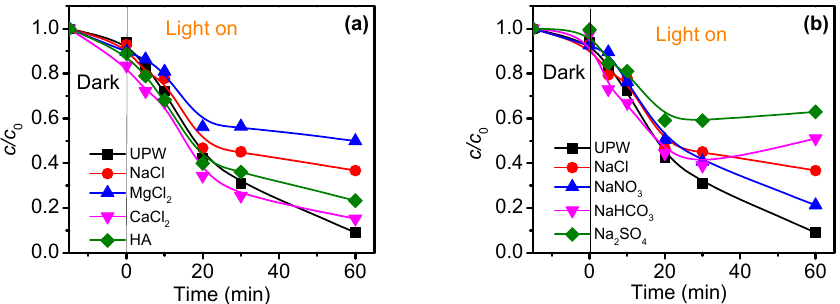
Figure 11. Effect of different cations and HA ( a ) and anions ( b ) on the FB 1 (1.39 μ mol/dm 3 ) removal efficiency using photocatalyst ZS–2 and UV irradiation at pH~8.